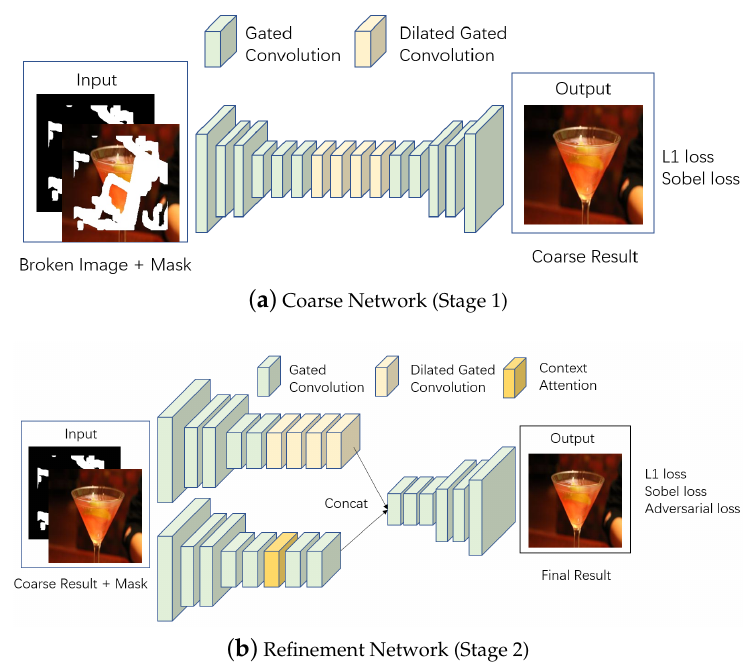
Figure 4. Overview of our